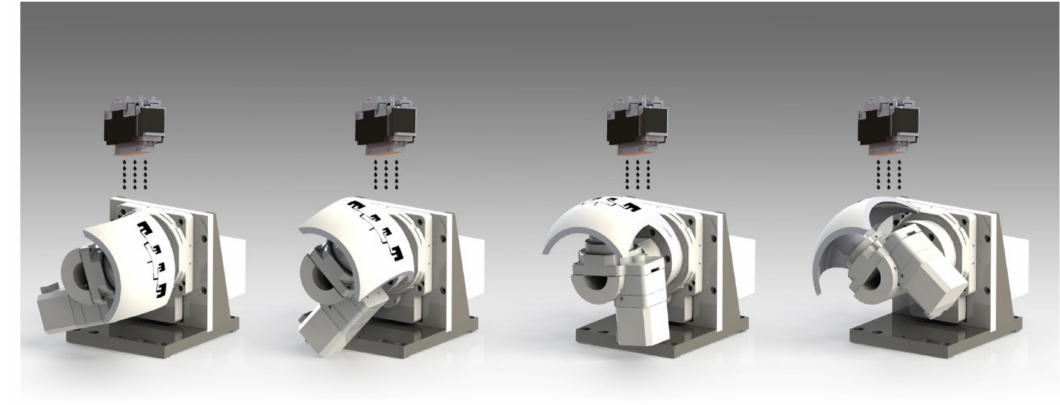
Figure 2. Process for printing the conformal antenna based on arrayed